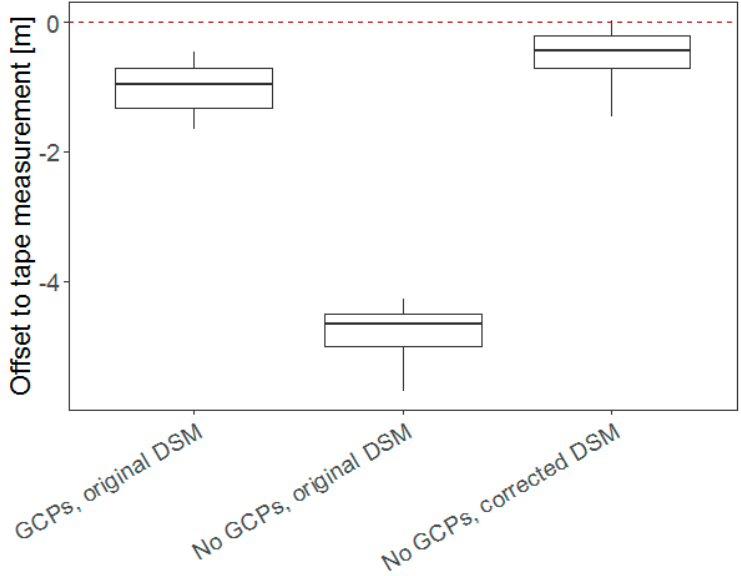
Figure 7. Boxplot analysis to investigate the effect of orientation quality on tree height measurements. The analysis was carried out with the dataset unmanned aerial vehicle (UAV)-Camera 2017 both with and without ground control points (GCPs). Calculations of tree height without GCPs were carried out both with the original digital surface model (DSM) and with the retrospectively corrected DSM.